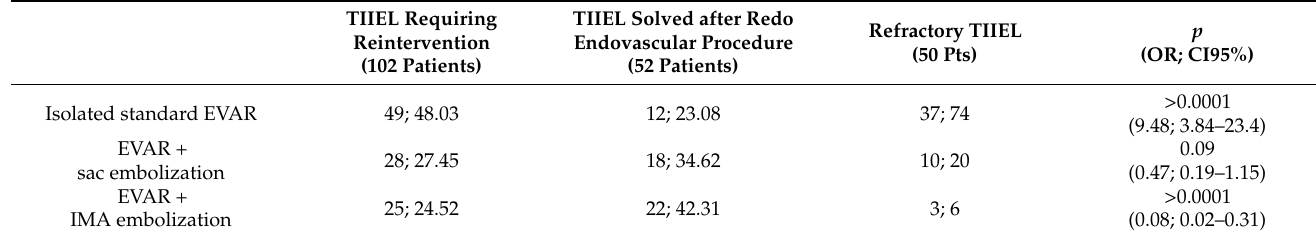
Table 4. Adjunctive procedures performed during initial EVAR in present series.